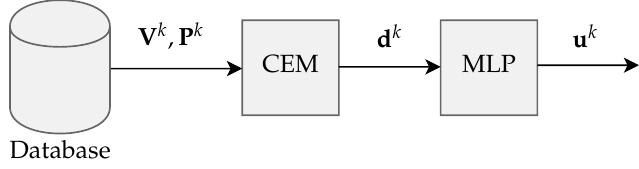
Figure 1. General structure of the proposed detection